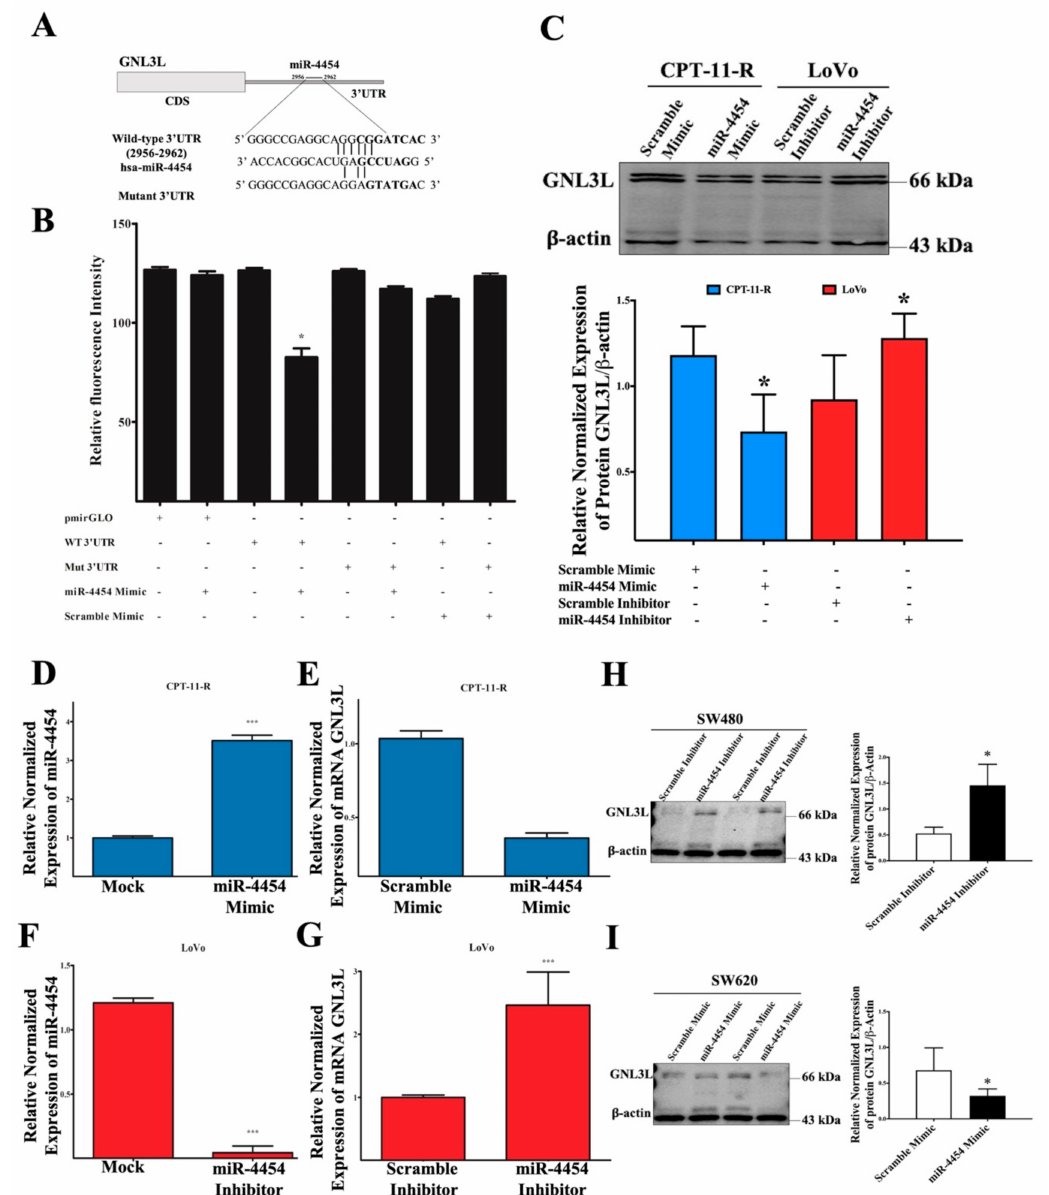
Figure 5. GNL3L is a functional target of miR-4454. ( A ) Schematic diagram of the miR-4454 binding target sequences of the wild-type and mutant 3’UTRs. ( B ) Luciferase reporter assay showing the relative luciferase intensity of wild-type and mutant GNL3L 3’UTR targeted by miR-4454 and the scramble. ( C ) Results from the Western blot analysis of GNL3L protein expression levels in CPT-11-R cells overexpressing miR-4454 and LoVo cells with inhibition of endogenous miR-4454. ( D ) Results from the q-RT-PCR analysis of CPT-11-R transient transfection e ffi ciency of miR-4454 overexpression, with the same conditions for ( E ) GNL3L mRNA expression and ( F ) LoVo endogenous miR-4454 inhibition e ffi ciency level as well as ( G ) for GNL3L mRNA expression level. ( H , I ) Results from the Western blot analysis of GNL3L protein expression level in SW480 (miR-4454 inhibitor) and SW620 (miR-4454 mimic) cells. The results are presented as mean ± standard error of the mean ( n = 3). * p < 0.05, *** p < 0.001 compared to